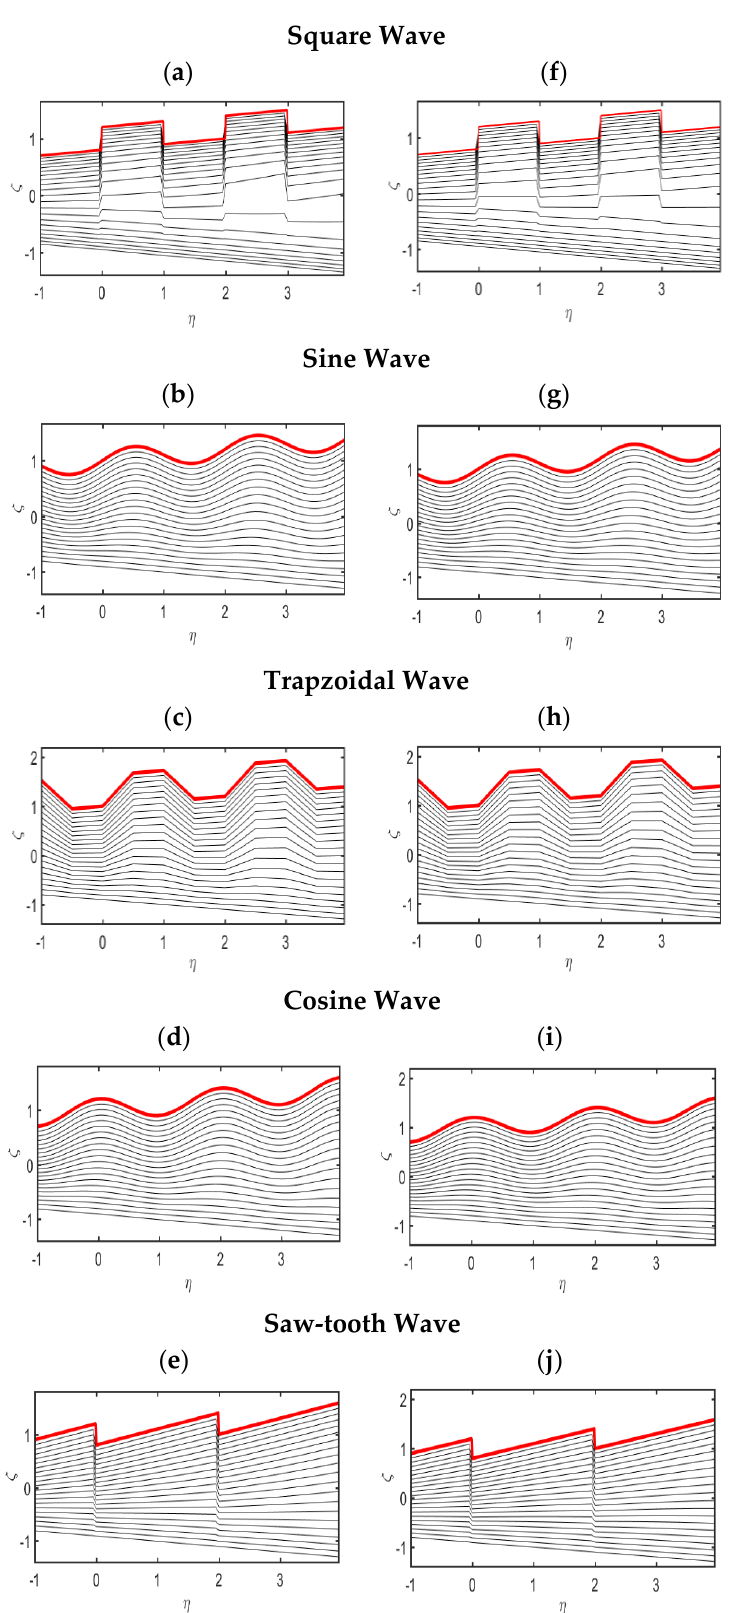
Figure 6. Trapping phenomena for curvature parameter (𝜎 = 3,∞) using ( a , f ) square wave, ( b , g ) sine wave, ( c , h ) trapezoidal wave, ( d , i ) cosine wave, ( e , j ) saw-tooth wave at 𝑞 = −2,𝐷𝐴 = 10,𝛼 = 0.1,𝛽 = 0.1,and 𝜙 = 0.2.